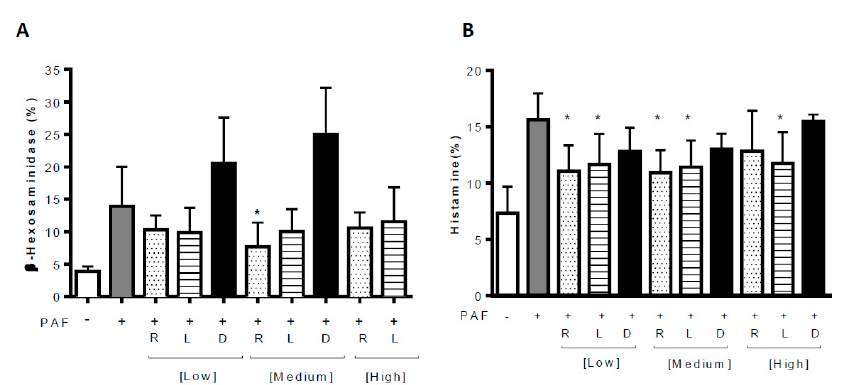
Figure 2. Effect of rupatadine, levocetirizine and desloratadine on PAF-induced ( A ) β -hexosaminidase and ( B ) histamine release in LAD2 cell line. R: rupatadine; L: levocetirizine; D: desloratadine. [Low]: 5 µM, [Medium]: 10 µM, [High]: 25 µM. * p < 0.05. (+) experimental condition with PAF. ( − ) experimental condition without PAF.